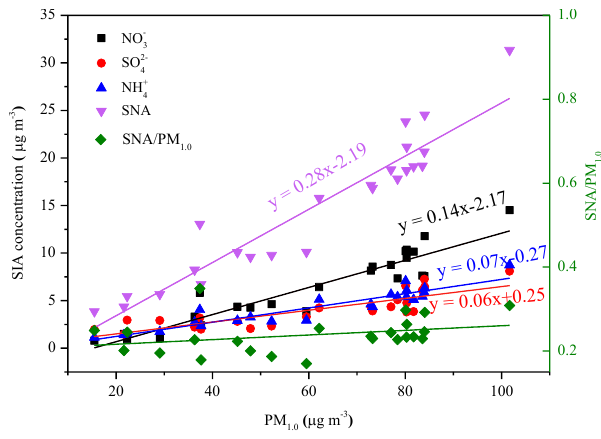
Figure 3. Variations of sulfate, nitrate, and ammonium concentra- tions as a function of PM 1 . 0 mass loading.